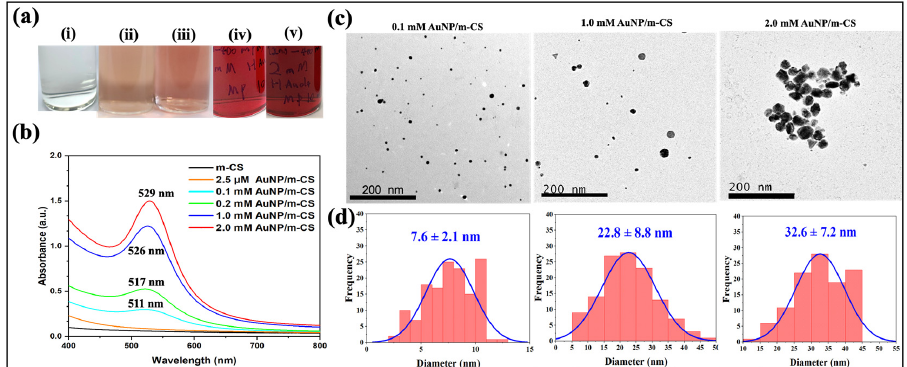
Figure 1. ( a ) Optical images of the as-prepared m-CS (i), 0.1 mM AuNP/m-CS (ii), 0.2 mM AuNP/m- CS (iii), 1.0 mM AuNP/m-CS (iv), and 2.0 mM AuNP/m-CS (v) nanocomposites. ( b ) UV-vis spectra